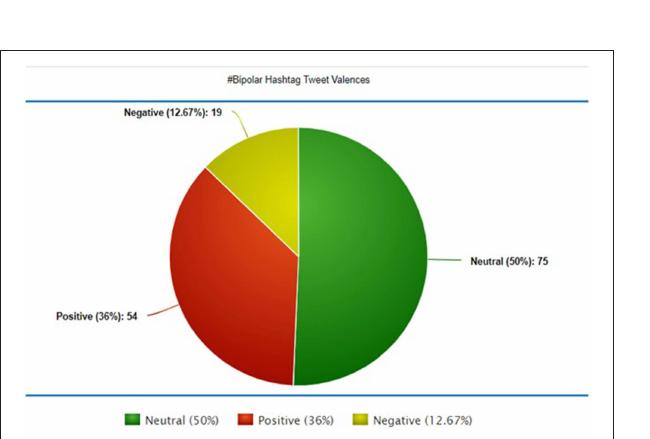
FIGURE 2 | Communication Goals of Opinion Leader’s Tweets on World Mental Health Day.